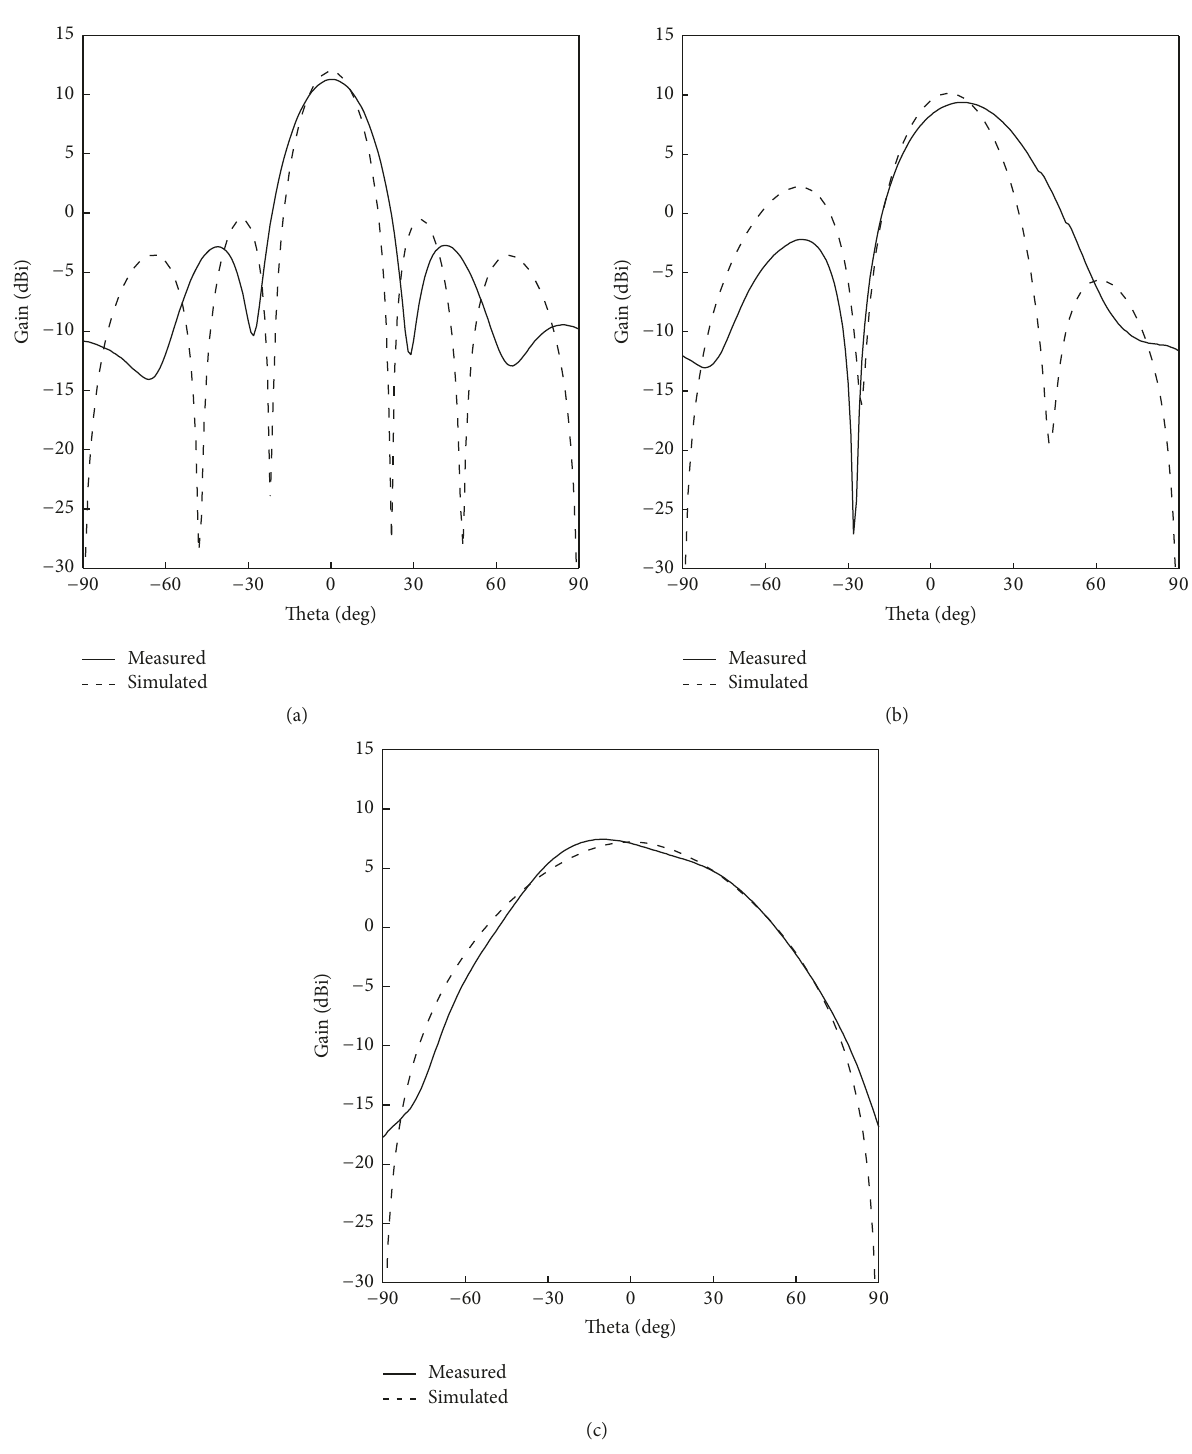
Figure 7: Measured radiation pattern with (a) 0, (b) 2, and (c) 4 shorting